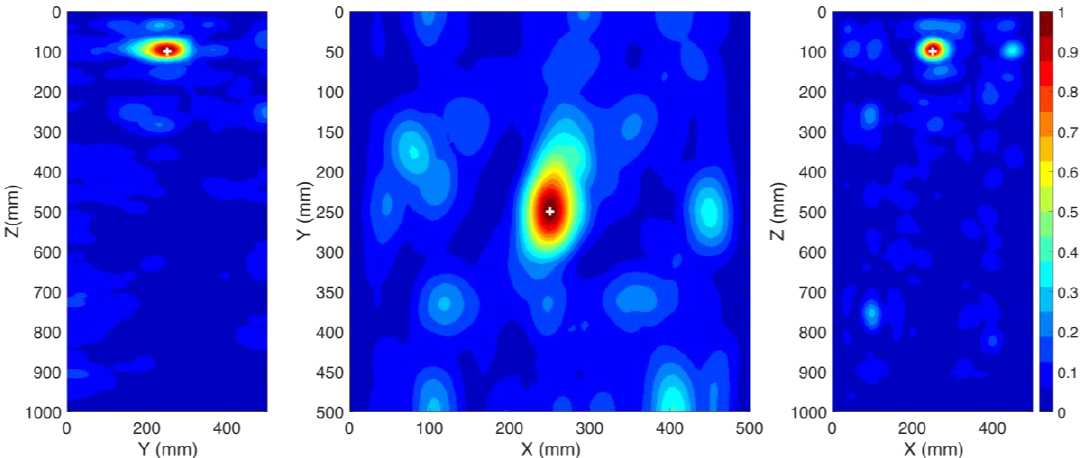
Figure 4. Normalized distribution of the maximum electric field power over the time inside the transformer tank (CS #2). The ground truth location of the PD source (PD1) is shown by the “ + ” marker. Only one sensor (S1) is used.